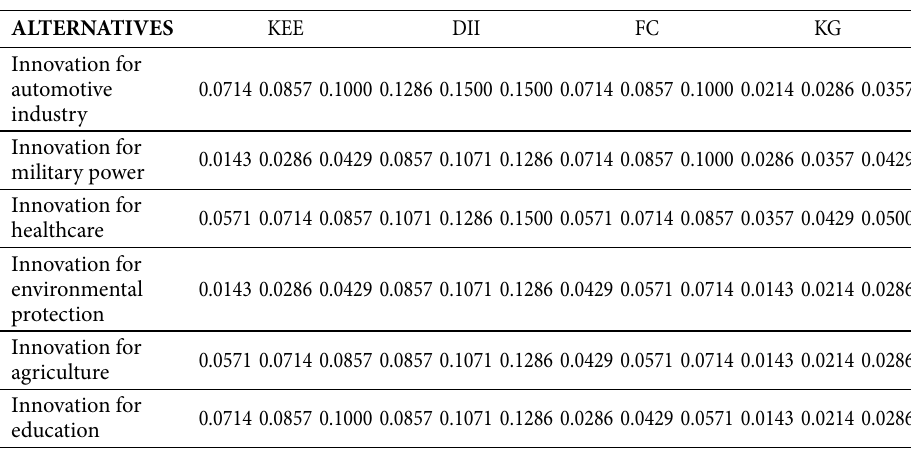
Table 5. Weighted fuzzy normalized decision